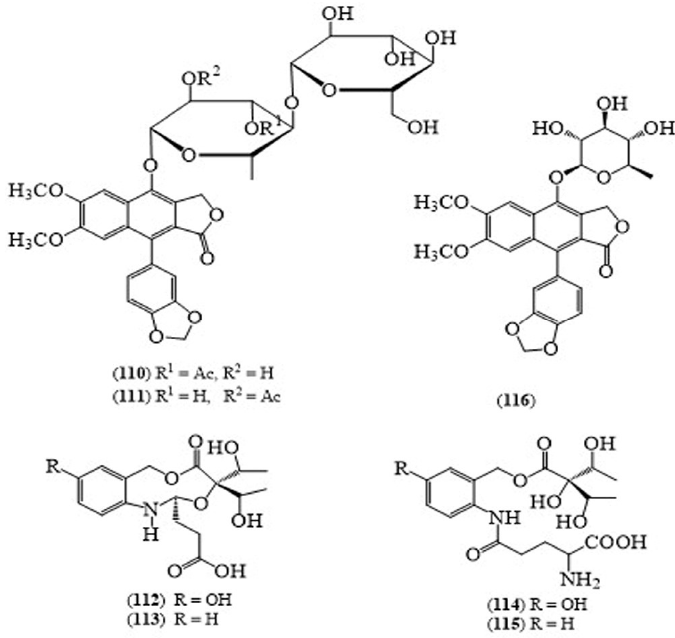
Figure 10. Structures of selected compounds isolated from Justicia gendarussa . 2.10. Premna integrifolia